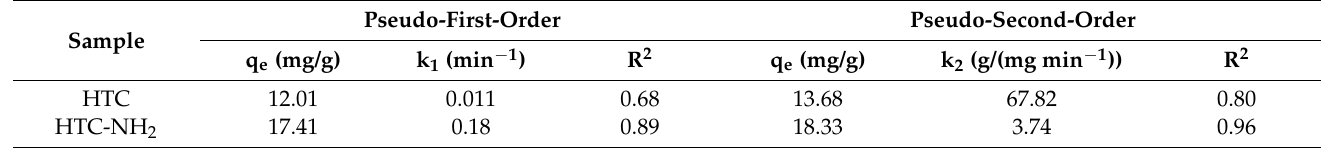
Table 2. Kinetic parameters for the adsorption process of